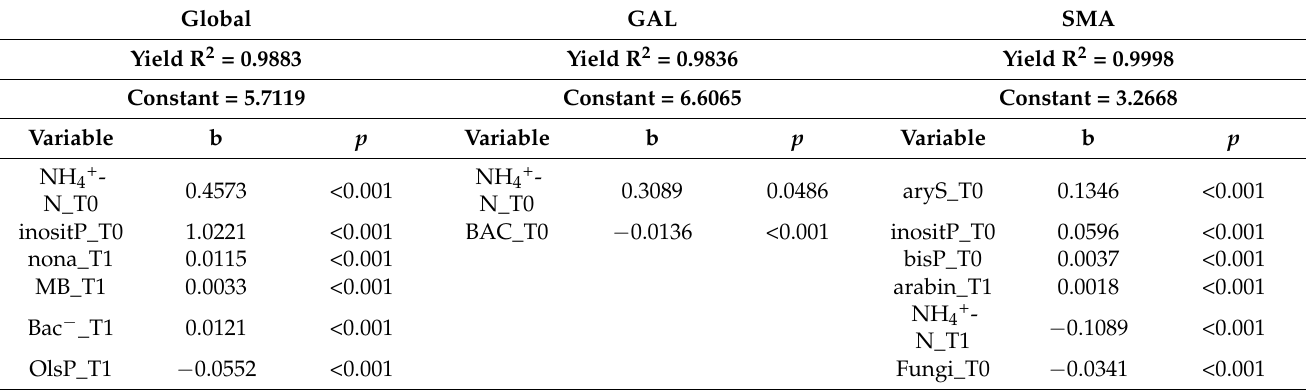
Table 4. Stepwise multiple linear regressions for the estimation of wheat grain yield, based on the soil variables described in the M&M section, for each experimental soil individually (GAL and SMA) and together (Global). Letter b represents the equation constant while letter p is the observed significance